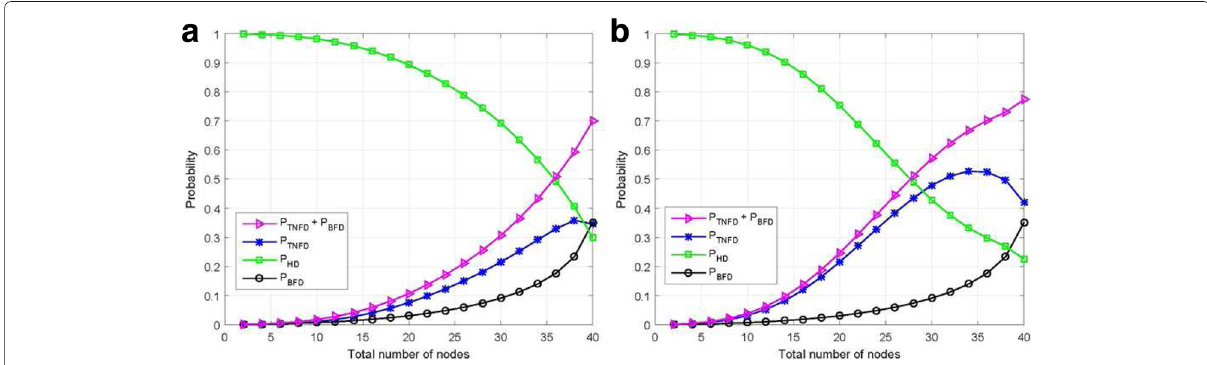
Fig. 10 Probability vs. total number of nodes. a Average HT ratio is 10%. b Average HT ratio is 30%